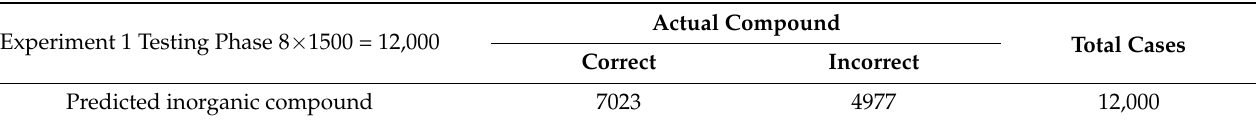
Table 11. Experiment 3 confusion matrix for the proposed CNN without the transfer learning using DS1 eightfold testing and (Map EE&VOL ) as input for training.